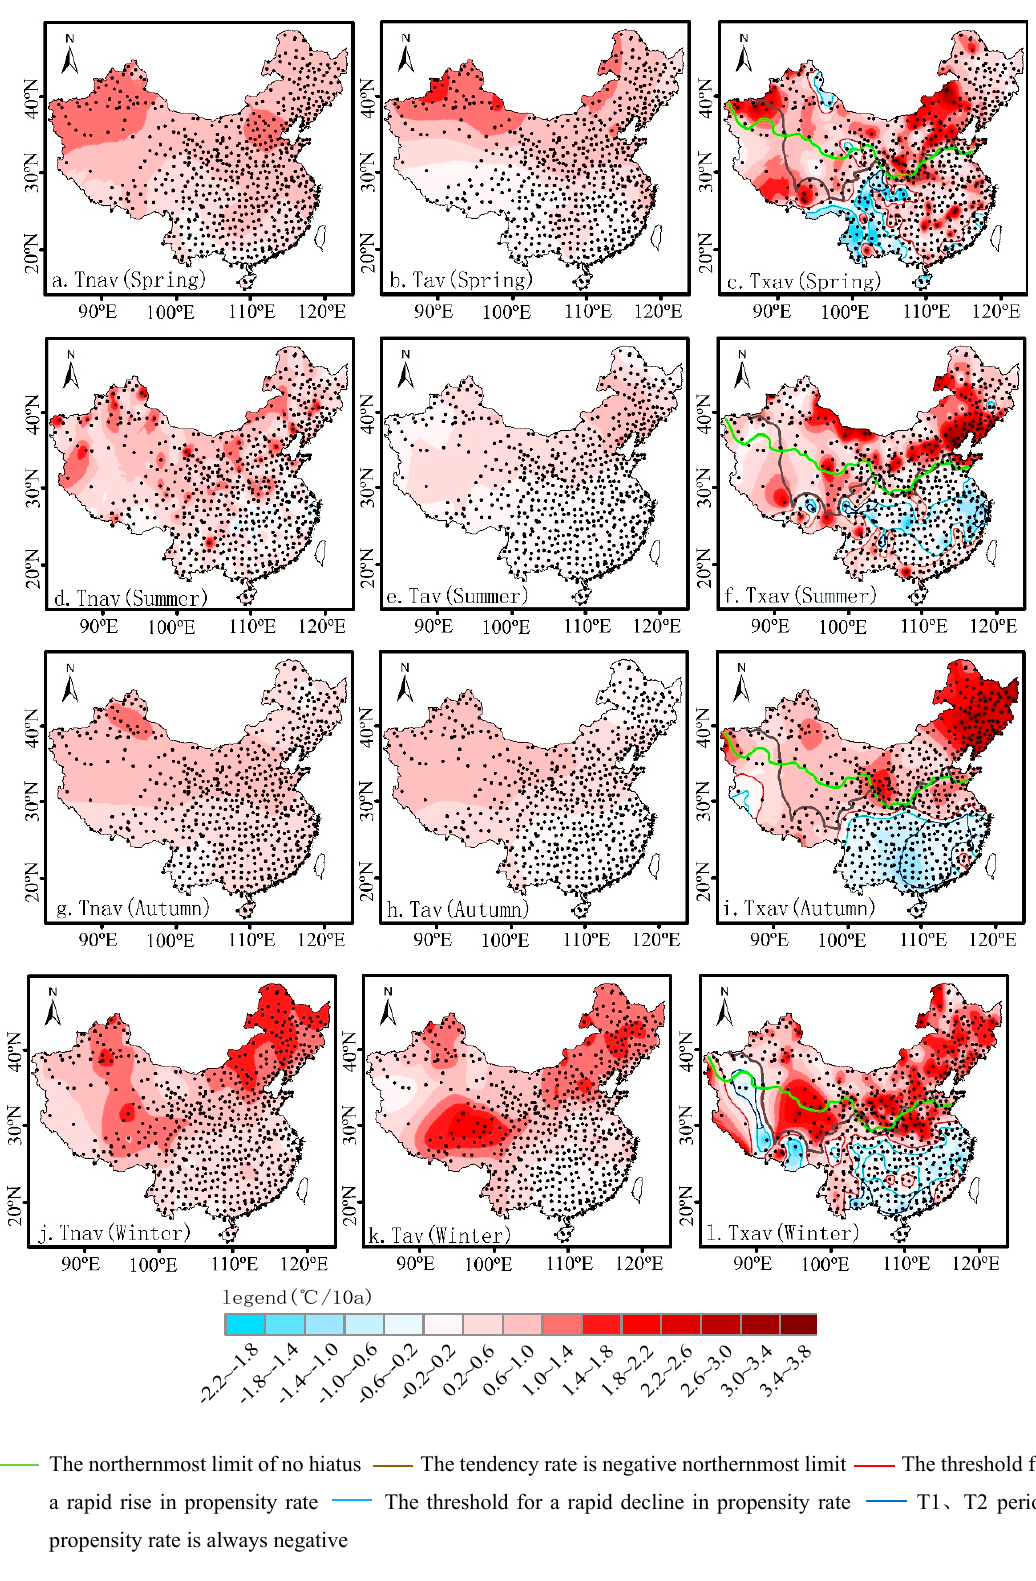
Figure 6. Spatial distribution of the tendency rates for the three temperature types in period T2 for each season of the study area.